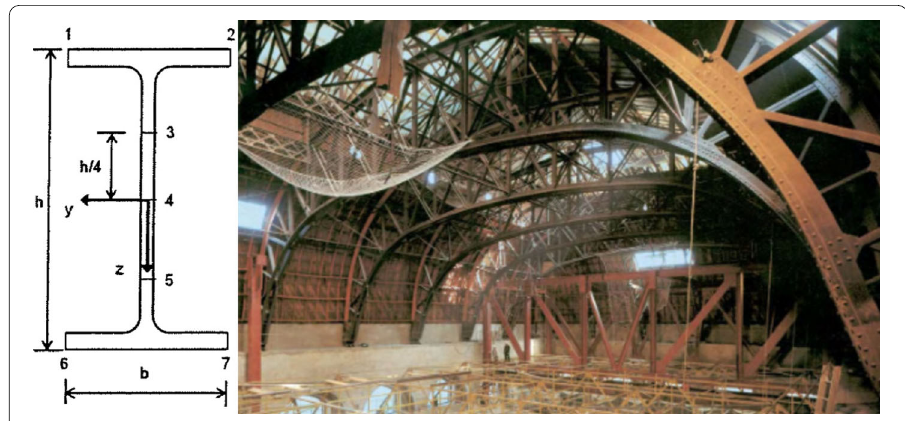
Figure 6 Left: The 7 traces times-of-flight are recorded in as a cross section (compare Abb. 5.25 in [9]). Right: An overview about the amount of beams and, thus, complexity of records and changes of the statical